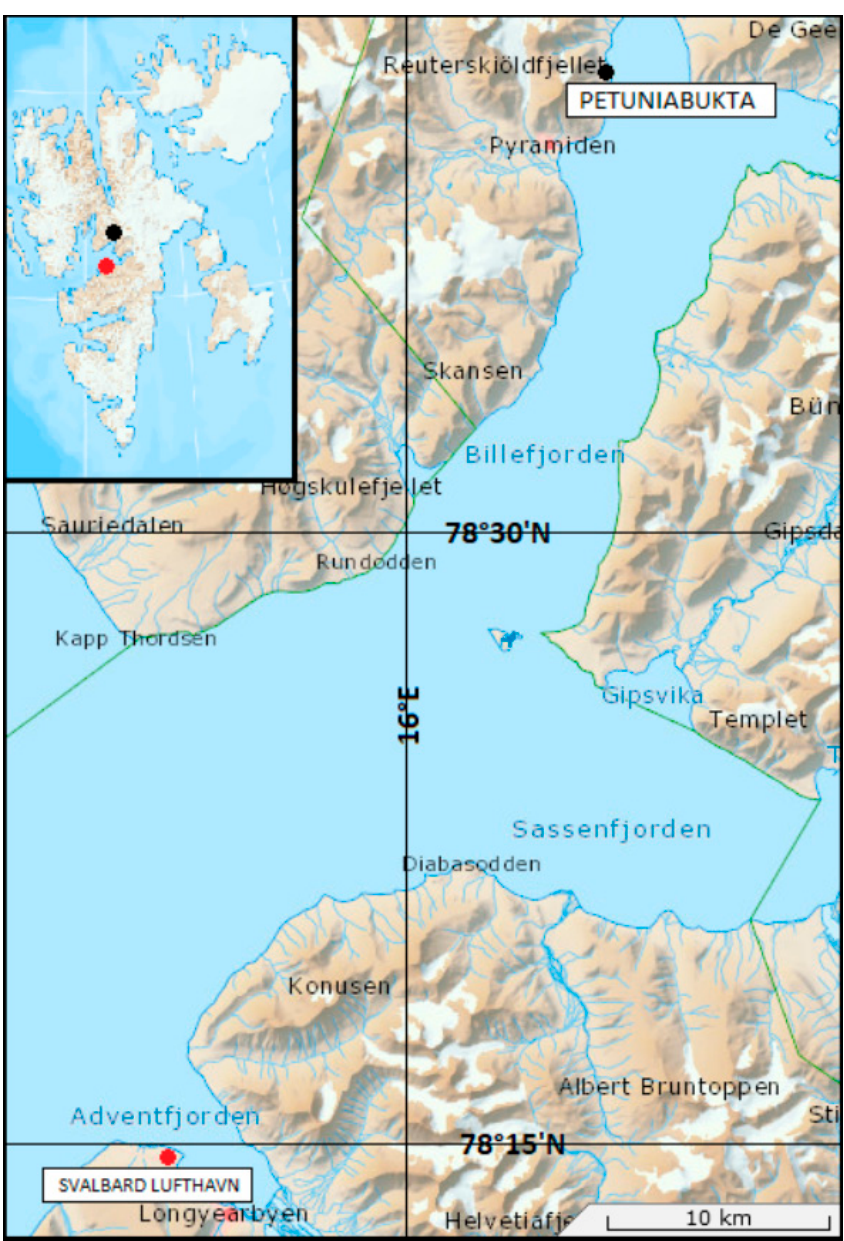
Figure 1. Location of research area including meteorological stations at Svalbard—Lufthavn and Petuniabukta. Based on: http://toposvalbard.npolar.no/ accessed on 10 May 2021